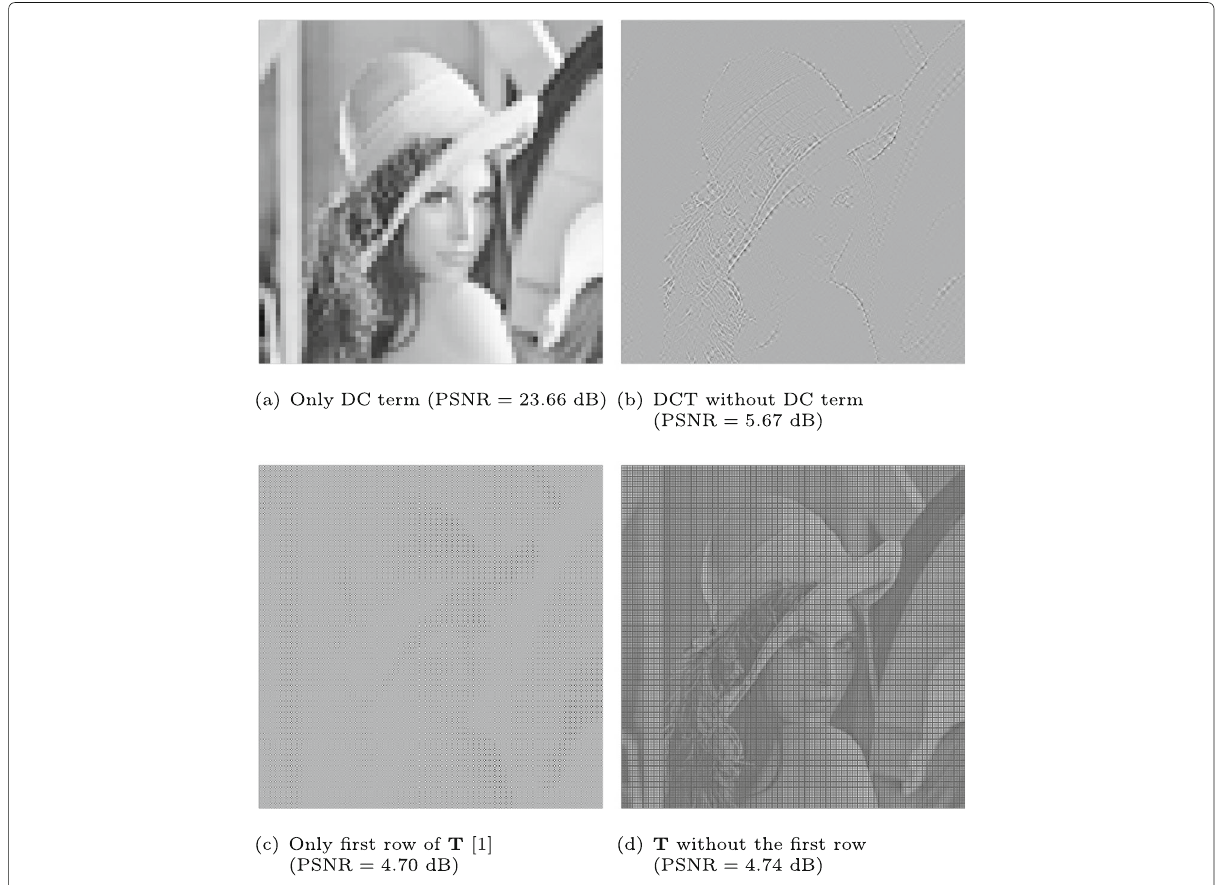
Fig. 1 Reconstructed Lena image based a only on the DC component of the DCT, b on all DCT transform coefficient except the DC component, c only on the first row of the T [1], and d on all T coefficients, except the first row